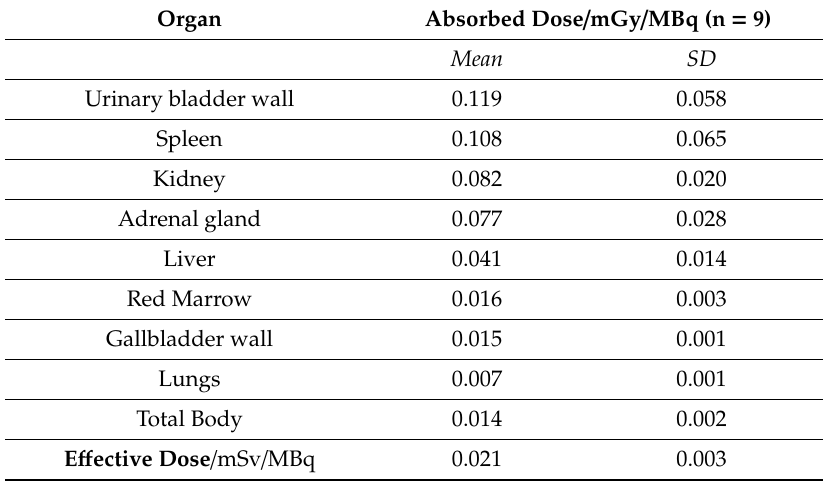
Table 1. Estimated radiation absorbed doses for [ 68 Ga]Ga-DOTA-TOC in selected organs [49].